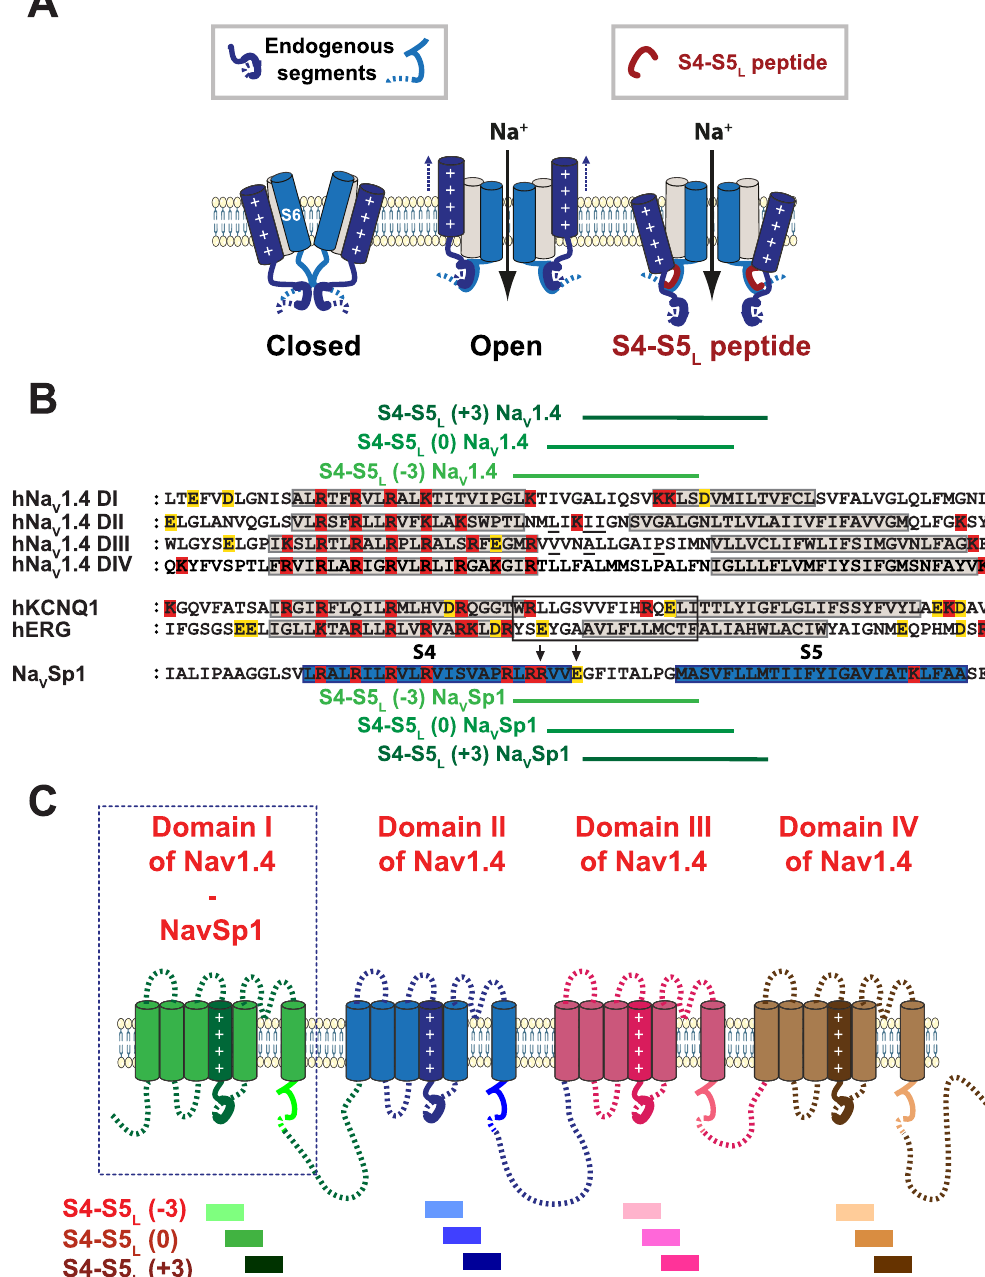
Figure 1. Ligand/receptor model. Multiple alignment used to design Na V Sp1 and Na V 1.4 S4-S5 L peptides. ( A ) scheme of the ligand/receptor model in which S4-S5 L (endogenous segment, deep blue) binds to S6 T (endogenous segment, light blue) to stabilize the channel in the open state, as suggested by works on Na V Ms channel. The S4-S5 L peptide (red) mimics endogenous S4-S5 L , stabilizing the channel open conformation. ( B) Multiple alignment used to design Na V Sp1 and hNa V 1.4 peptides from previously potent hK V 7.1 and hK V 11.1 S4-S5 L peptides (framed). Starting from S4-S5 L ( − 3) peptide, two others peptides were designed, by shifting toward the C-terminus by 3 (S4-S5 L (0)) and 6 amino acids (S4-S5 L ( + 3)). Red: basic residues, yellow: acidic residues. Colored boxes represent the S4 and S5 segments. Mutated residues in skeletal channelopathies are underlined (in Na V 1.4 S4-S5 L ). Arrows point to Na V Ms-corresponding residues interacting with S6 T (text) C : Scheme of the hNa V 1.4 and Na V Sp1 channels showing the color used for each